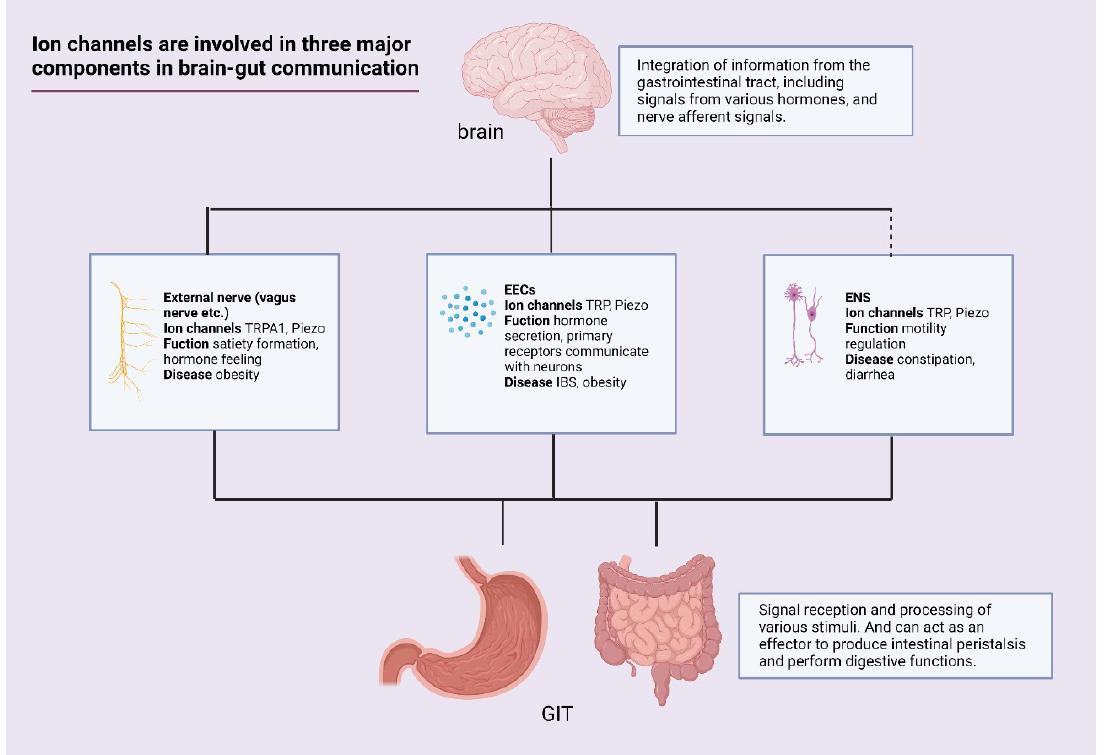
Figure 2. Ion channels involved in three major components in brain-gut communication. There are three important components involved in digestion and feeding regulation, including externally innervated nerves of the gut, EECs, and enteric nervous system (ENS). (1) Externally innervated nerves are able to acquire information in the gut; some neurons can directly sense stimuli, while others acquire information about the state of the gut by sensing hormones secreted by EECs. The regulation of satiety signals can be used to experimentally regulate diseases such as obesity. (2) EECs are important signal receptors in the intestine. They are able to make direct contact with intestinal contents and integrate various signals to regulate their own secretory function. These secreted hormones have important roles in the regulation of intestinal homeostasis. For example, we can use the effect of 5-HT on intestinal dynamics to regulate irritable bowel syndrome (IBS), as well as GLP-1 on obesity. (3) The ENS is an independent part that receives information from EECs and extrinsic nerves and is able to form complex neural loops that control intestinal dynamics and exert a regulatory effect on intestinal dynamics. Further studies on ENS are expected to have good therapeutic targets in controlling intestinal dynamics-related diseases such as constipation and diarrhea. (created with BioRender.com)